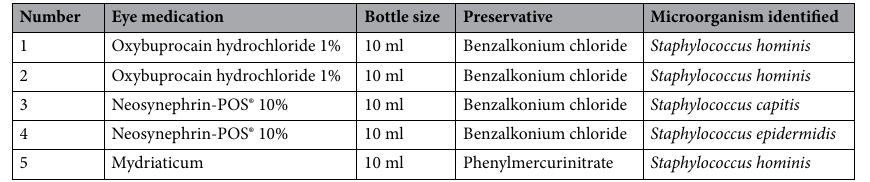
Table 1. Overview of contaminated multi-dose eyedrop bottles with respective eye medication, bottle size, preservative, and microorganism identified.